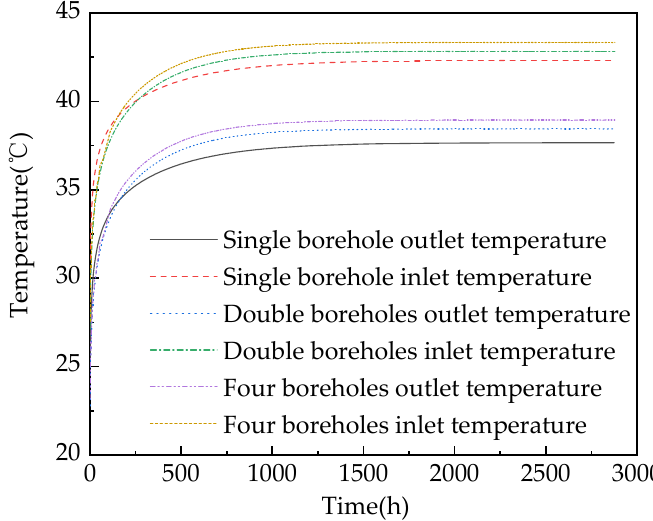
Figure 8. Changes in the inlet and outlet temperatures in summer.